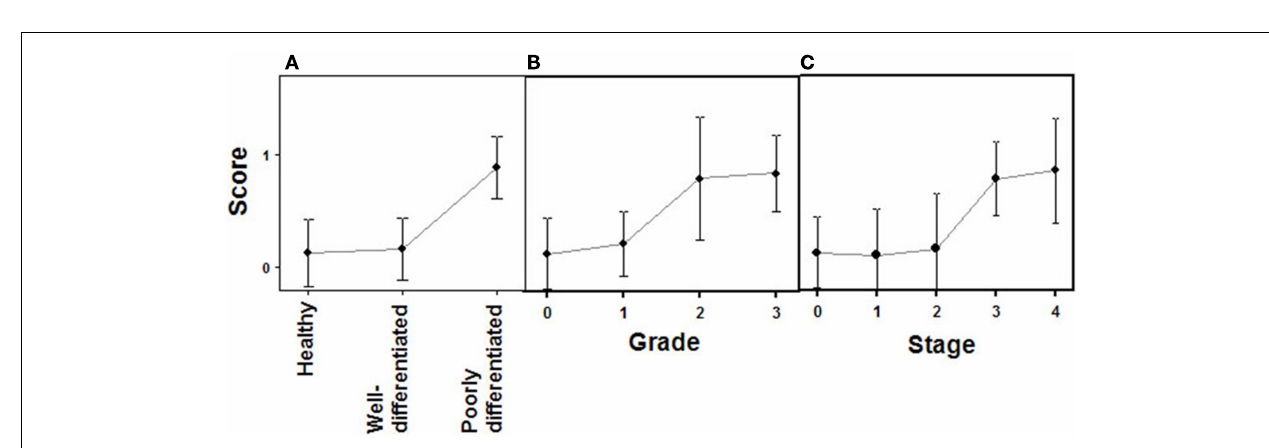
FIGURE 8 | Immunohistochemical staining of glypican 5 in NETs . (A,B,D,G,J) Well-differentiated NETs; tumors not expressing GPC5 from colon (A) , lung (D) , small intestine (G) and pancreas (J) , and displaying positive reaction from colon (B) .